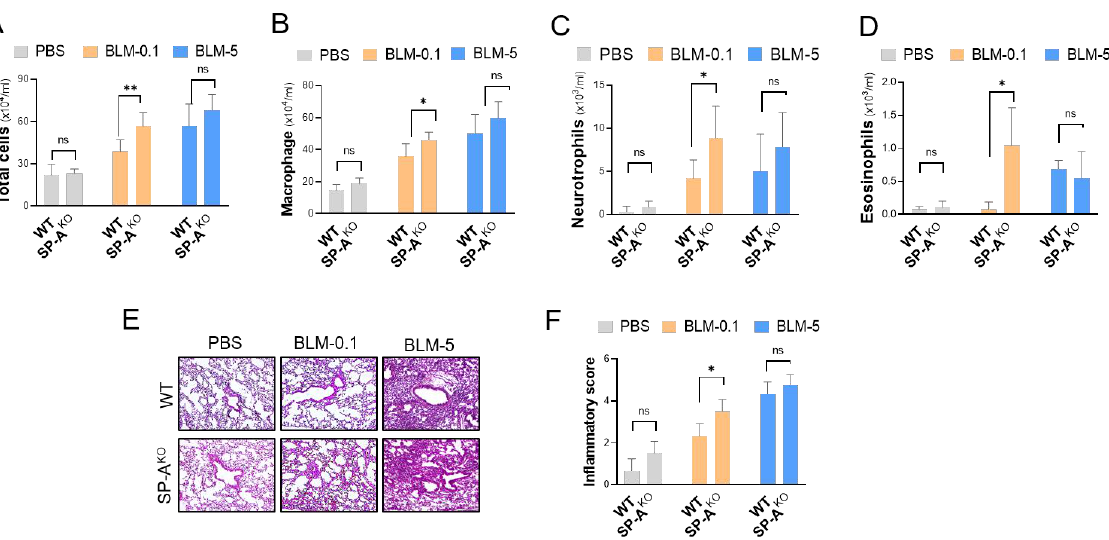
Figure 3. SP-A deficiency increases inflammatory cell accumulation in mice induced with a low dose of BLM. ( A – D ) Inflammatory cells in the BAL fluid of SP-A knockout mice following BLM treatment were counted to determine the total cell number ( A ), as well as the numbers of macrophages ( B ), neutrophils ( C ), and eosinophils ( D ). ( E , F ) Representative images of hematoxylin and eosin (H&E)- stained lung tissues and semiquantitative analysis of inflammation indices. The data are presented as the mean ± SE. * p < 0.05, ** p < 0.01. ns indicates no significant difference between groups. WT group: control lentivirus-injected mice; SP-A KO group: lentivirus targeting SP-A-injected mice;